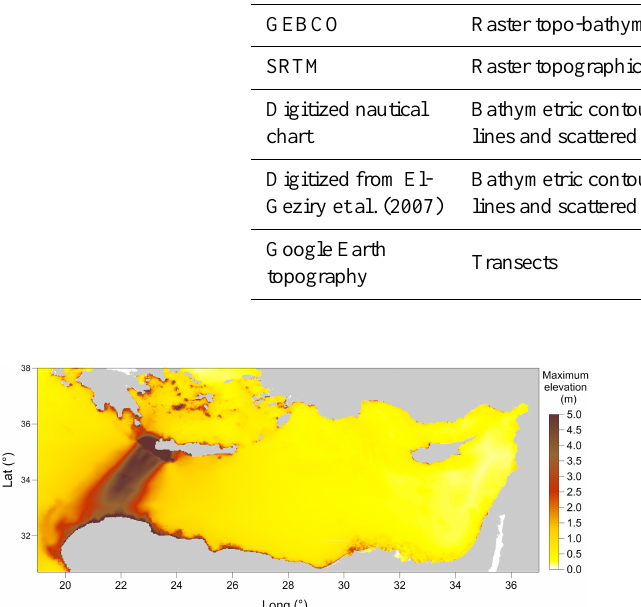
Figure 3. Sea surface maxima in grid 1 for the tsunami generated by the western Hellenic Arc (WHA) earthquake (see Table 1 for